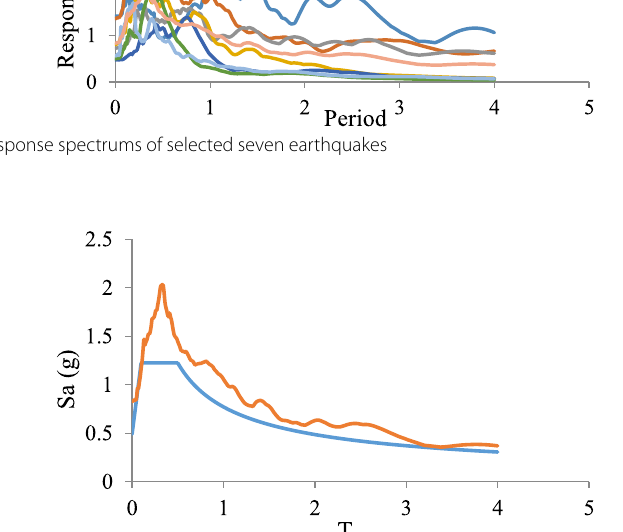
Fig. 5 The comparison of the response spectrum of Iranian Standard No. 2800 with the response spectrum obtained from the average response spectrum of the selected seven earthquakes